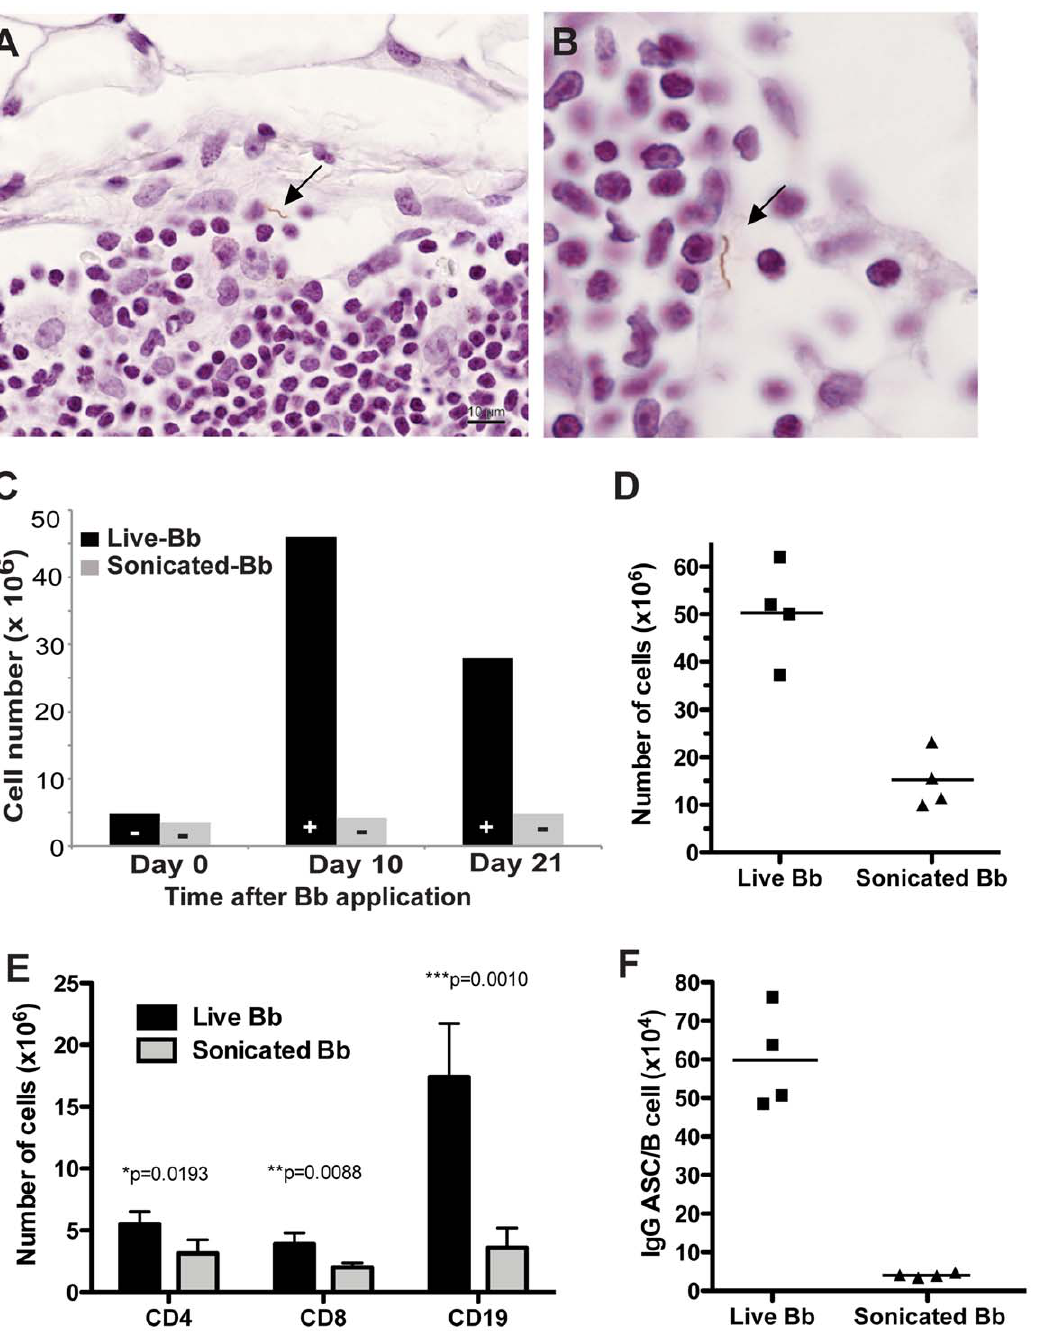
Figure 3. B.burgdorferi localizes to the subcapsular sinus of lymph nodes. ( A, B ) Immunohistochemistry with polyclonal B. burgdorferi - specific rabbit serum, demonstrates the presence of extracellular B. burgdorferi spirochete (arrow) in the subcapsular sinus of the right inguinal lymph node of C57BL/6 mice infected by tissue-transplant eight days prior to analysis. ( C ) Shown are mean cell numbers of right inguinal lymph nodes of C57BL/6 mice (n=2 per timepoint) either infected via injection of 10 4 culture-grown live (live) or heat-killed and sonicated B. burgdorferi in PBS. ‘‘ + ’’ identifies positive B. burgdorferi cultures of lymph nodes (n=2 per timepoint) from the same group of mice, ‘‘ 2 ’’ shows lack of B. burgdorferi growth in culture. Results are from one of two independent experiments that gave similar results. ( D – F ) Comparison of mice infected as in (C) but injected with 10 6 inactivated B. burgdorferi for 8 days prior to analysis ( D ) Total numbers of cells recovered from lymph nodes. Each symbol represents results from one animal; horizontal bars indicate the mean for the group. ( E ) Data shown are total numbers CD4, CD8 T cells and CD19 B cells calculated from total cell counts and frequencies of cell subsets as determined by flow cytometry. ( F ) Shown are frequencies of IgG antibody-secreting cells in lymph nodes of mice given live or inactivated B. burgdorferi . Note data are normalized to B cell numbers. Each symbol represents the results from one mouse; the horizontal line indicates the mean for the group.